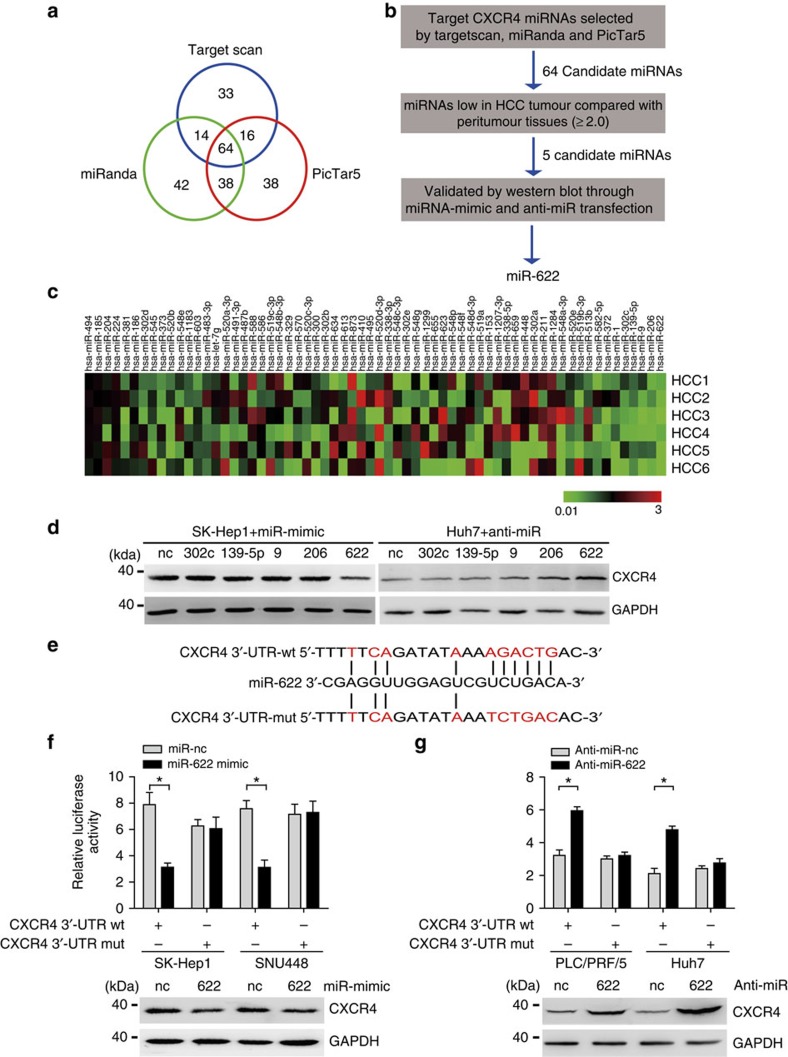
CXCR4 is a direct miR-622 target.(a) Schema of the candidate miRNAs by different prediction algorithms. Each labelled circle represents one prediction algorithm with the number of its predicted miRNAs, and the number listed in overlapping of circles is simultaneously predicted by different algorithms. (b) Schematic model for miRNA screening to target CXCR4. (c) Heatmap obtained from RT–PCR of HCC and corresponding peritumour specimens. Each column represents the average of three biological replicates. The relative high expression is indicated in red, whereas the relative low expression is in green. (d) Western blot analysis of CXCR4 and GAPDH for SK-Hep1 cells transiently transfected with miR-nc, miR-302c, miR-139-5p, miR-9, miR-206 and miR-622 mimic (left panel) and for Huh7 cells transiently transfected with anti-miR-nc, anti-miR-302c, anti-miR-139-5p, anti-miR-9, anti-miR-206 and anti-miR-622 (right panel). Data are representative immunoblots of three independent assays. (e) Sequences of miR-622 and the potential miR-622-binding sites at the 3′-UTR of CXCR4. Also shown are nucleotides mutated in CXCR4-3′-UTR mutant. Seed sequences are marked. (f) Luciferase activity assay for pGL3-CXCR4 3′-UTR (wt) or pGL3-CXCR4 3′-UTR (mut) relative to Renilla luciferase activity for SK-Hep1 and SNU448 cells transiently transfected with miR-nc or miR-622-mimc (n=3, upper panel). Student's t-test, *P<0.05. Error bars in panels are defined as s.d. Western blot analysis of CXCR4 and GAPDH for SK-Hep1 and SNU448 cells transiently transfected with miR-nc and miR-622-mimc (lower panel). Data are representative immunoblots of three independent assays. (g) Luciferase activity assay for pGL3-CXCR4 3′-UTR (wt) or pGL3-CXCR4 3′-UTR (mut) relative to Renilla luciferase activity for PLC/PRF/5 and Huh7 cells transiently transfected with anti-miR-nc or anti-miR-622 (n=3, upper panel). Student's t-test, *P<0.05. Error bars in panels are defined as s.d. Western blot analysis of CXCR4 and GAPDH for PLC/PRF/5 and Huh7 cells transiently transfected with anti-miR-nc or anti-miR-622 (lower panel). Data are representative immunoblots of three independent assays.